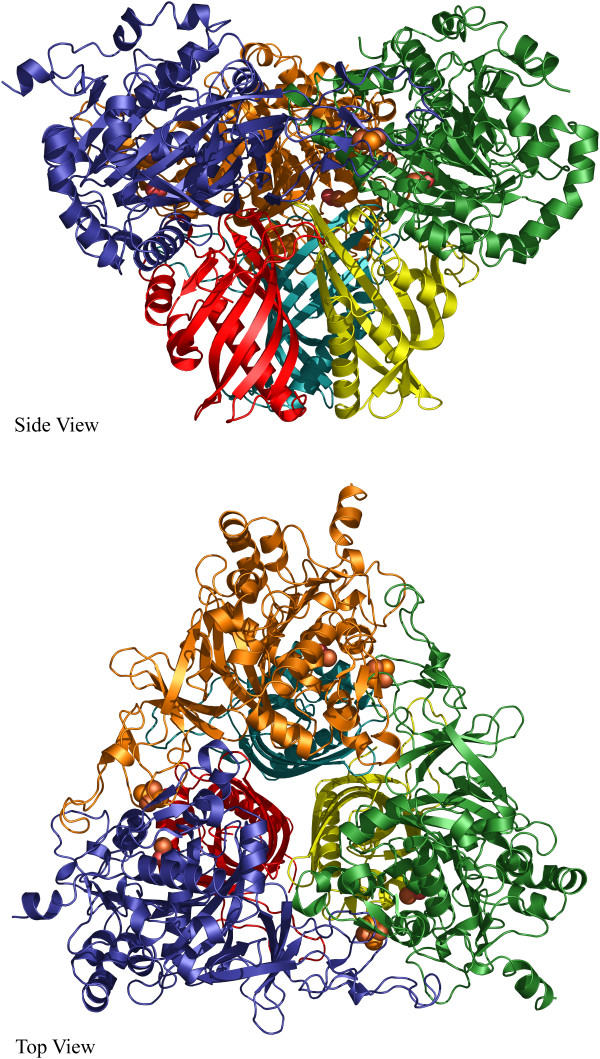
Top and side view of the BPDO-OB1 hexamer. The structure of biphenyl 2,3-dioxygenase is a mushroom-shaped α3β3 hexamer. This quaternary structure is typical of αβ Rieske oxygenases. This structure allows a mononuclear iron from one α subunit to come within ~15 Å of a Rieske cluster from a neighboring subunit, allowing electron transfer to take place.